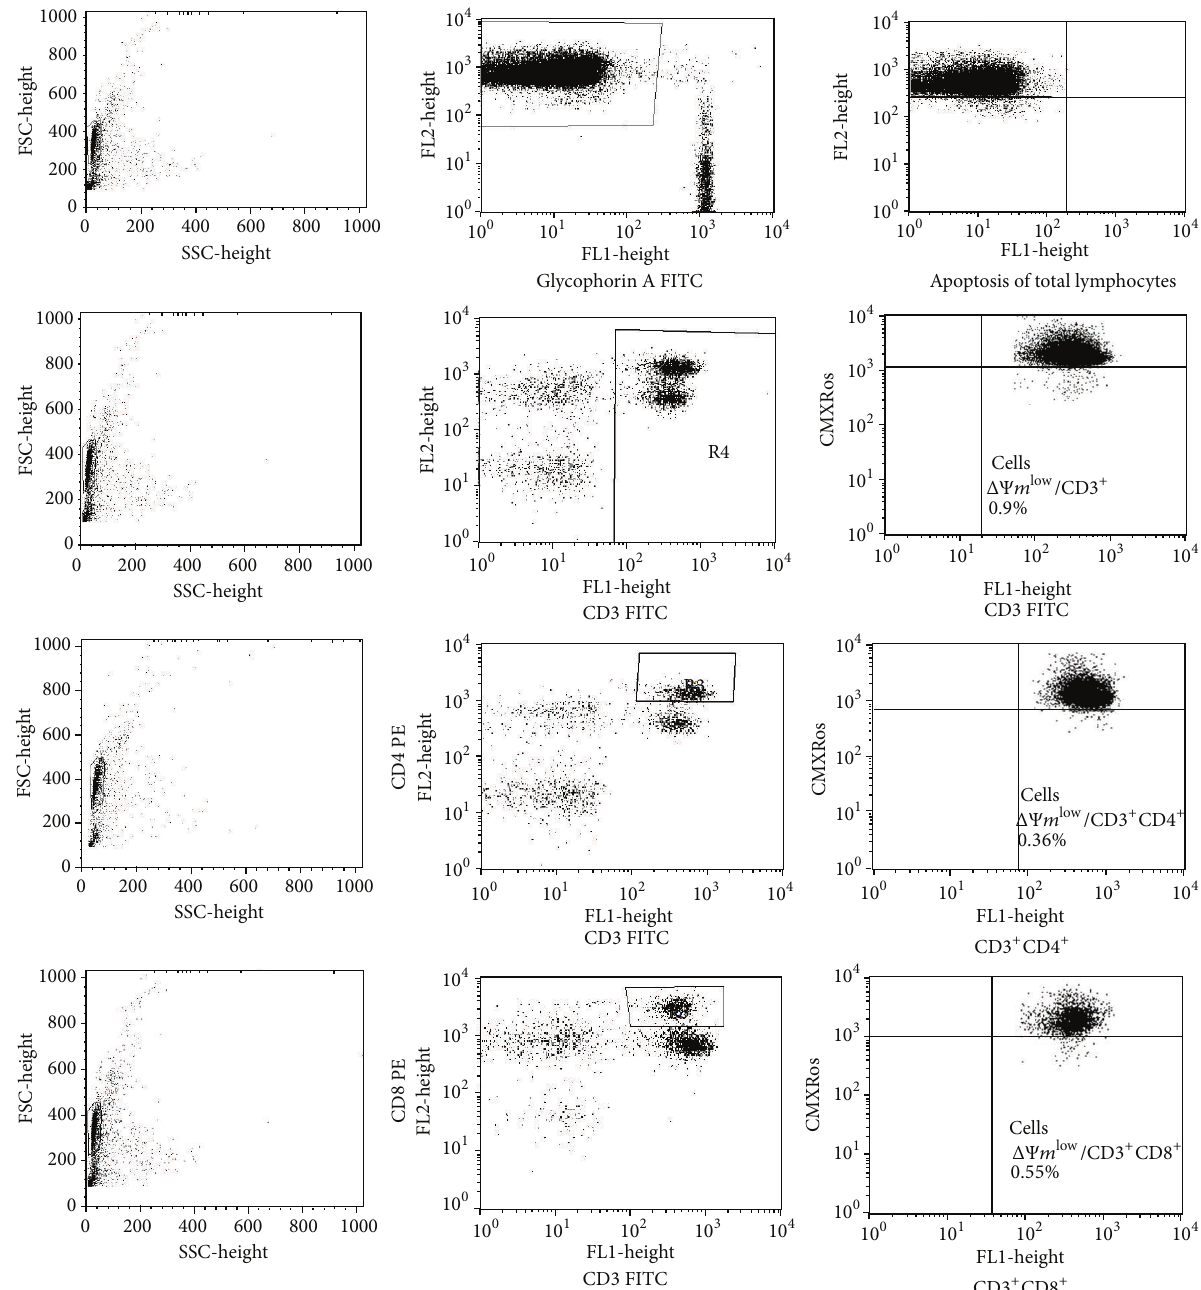
Figure 1: The strategy of gating and analyzing of total apoptotic lymphocytes and T CD3 + , T CD3 + CD4 + , and T CD3 + CD8 + apoptotic